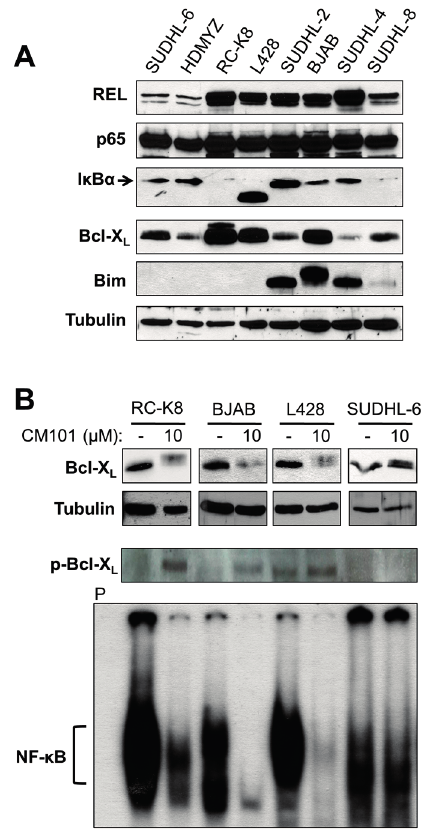
Figure 5. Total cellular levels of REL generally correlate with the sensitivity of B-lymphoma cells to CM101-induced apoptosis. ( A ) Extracts from the indicated B-lymphoma cell lines were probed by western blotting for REL, p65, I κ B α , Bcl-X L , and Bim. β -Tubulin western blotting was performed as a loading control. ( B ) B-lymphoma cell lines RC-K8, L428, BJAB and SUDHL-6 were treated for 24 h with either the solvent methanol ( − ) or 10 μ M CM101 (+). Anti-Bcl-X L , anti-phospho-Bcl-X L and β -tubulin (loading control) western blotting was then performed on whole-cell extracts (upper three panels). In the lower panel, the indicated cell extracts (RC-K8, 10 µg; BJAB, 10 µg; L428, 15 µg, SUDHL-6, 80 µg) were analyzed by EMSA with a κ B site-containing probe. P designates an EMSA lane containing the probe